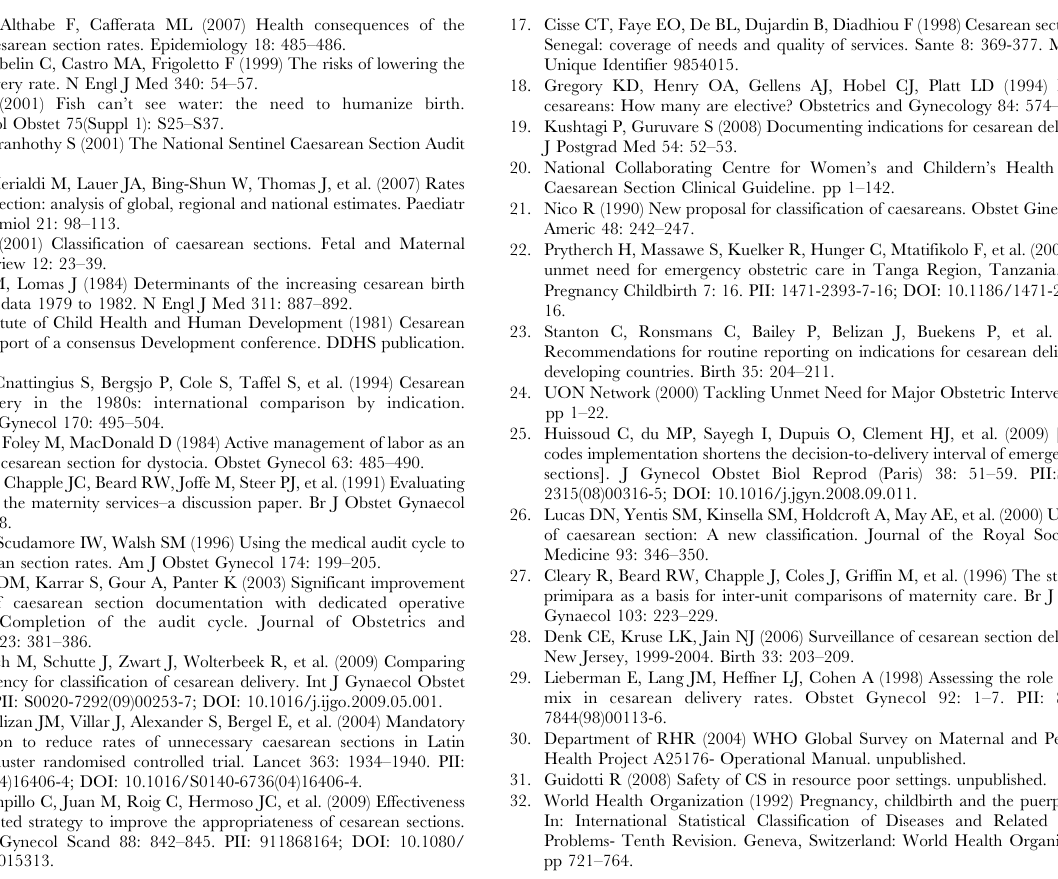
Figure S2 Search Strategy for CS classifications. Search strategy used for systematic review.